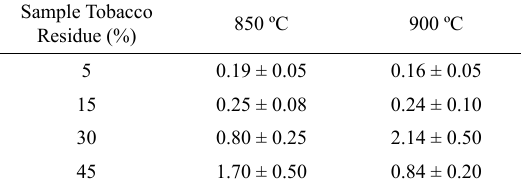
Table 3. Mean pore size of the glass foams produced containing 5, 15, 30 and 45% (mass) of T and fired at 850 and 900 ° C. Sample Tobacco Residue (%)